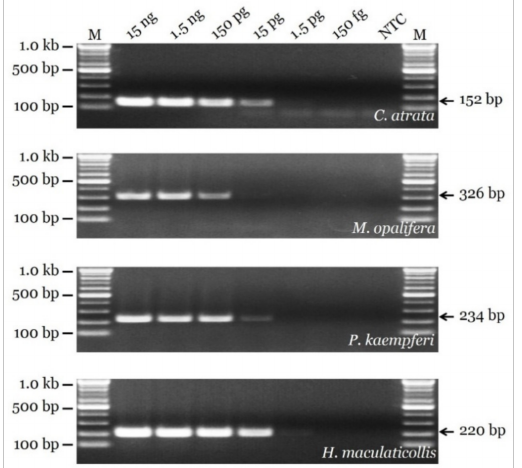
Figure 3. PCR sensitivity of newly developed SCAR markers evaluated using serially diluted template DNA. Lane M represents 100 bp DNA ladder. Arrows indicate precise sizes of PCR products.